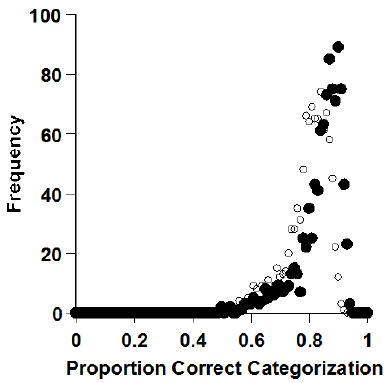
Figure 8. The frequency with which the prototype and exemplar process (filled and open circles, respectively) categorized transfer items at different accuracy levels in a family-resemblance task.